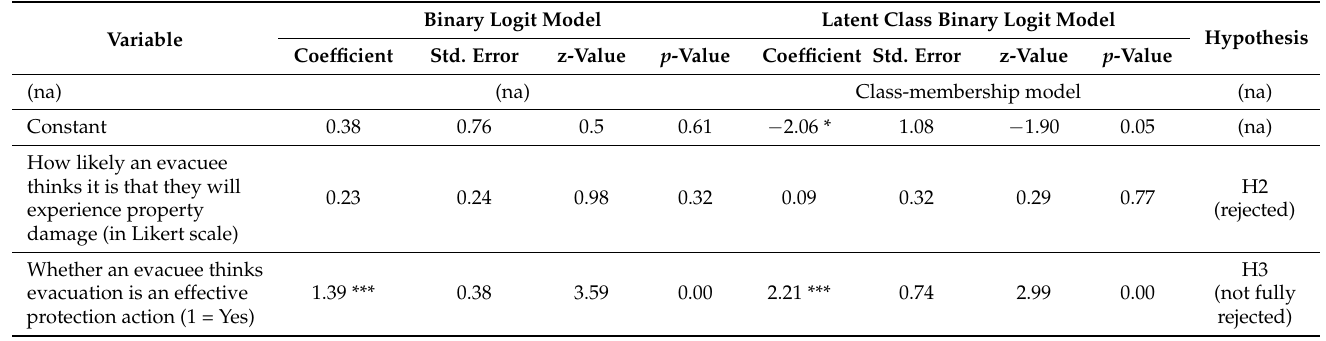
Table 2. Model estimation